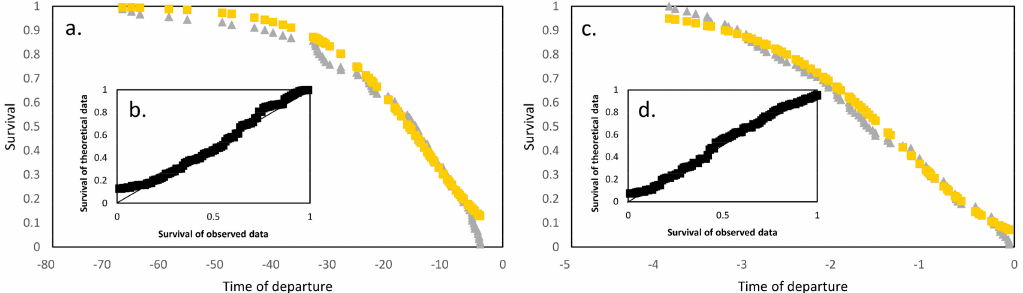
Figure 3. Survival analysis of departure time(s) at the red light for the observed data (grey) and for the theoretical data (yellow) ( a ) before − 4 s and ( c ) between − 4 and 0 s. Survival curves of theoretical data compared to survival of observed data; ( b ) before − 4 s and ( d ) between − 4 and 0 s. The thin black line represents the correlation we should observe between the two survivals if the rule underlying the departure of a pedestrian follows only one rule (here, a sigmoid curve, Equation (1)). For Figure 3a,c, 0 indicates the time at which the light turns green.